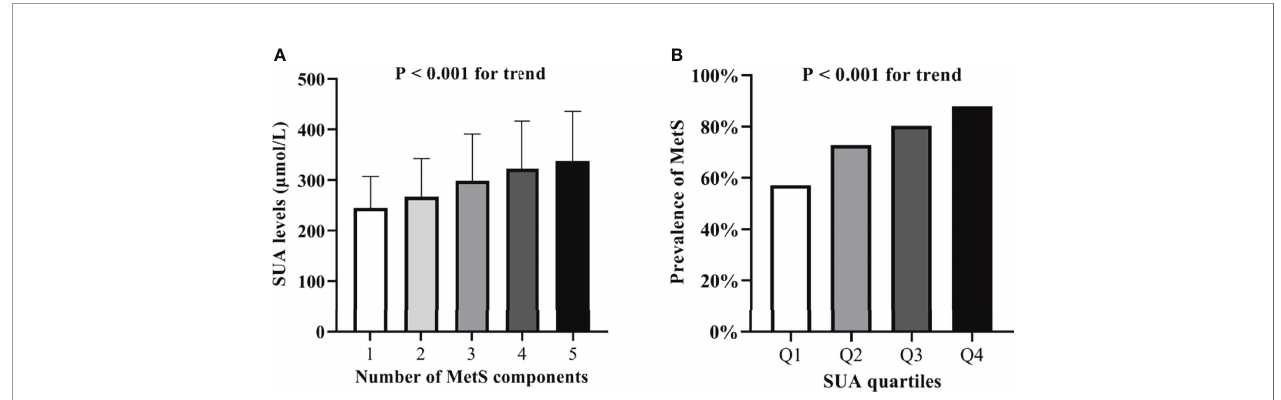
FIGURE 1 | (A) Serum uric acid levels according to the number of MetS components. (B) Comparison of the prevalence of MetS among the four SUA quartile